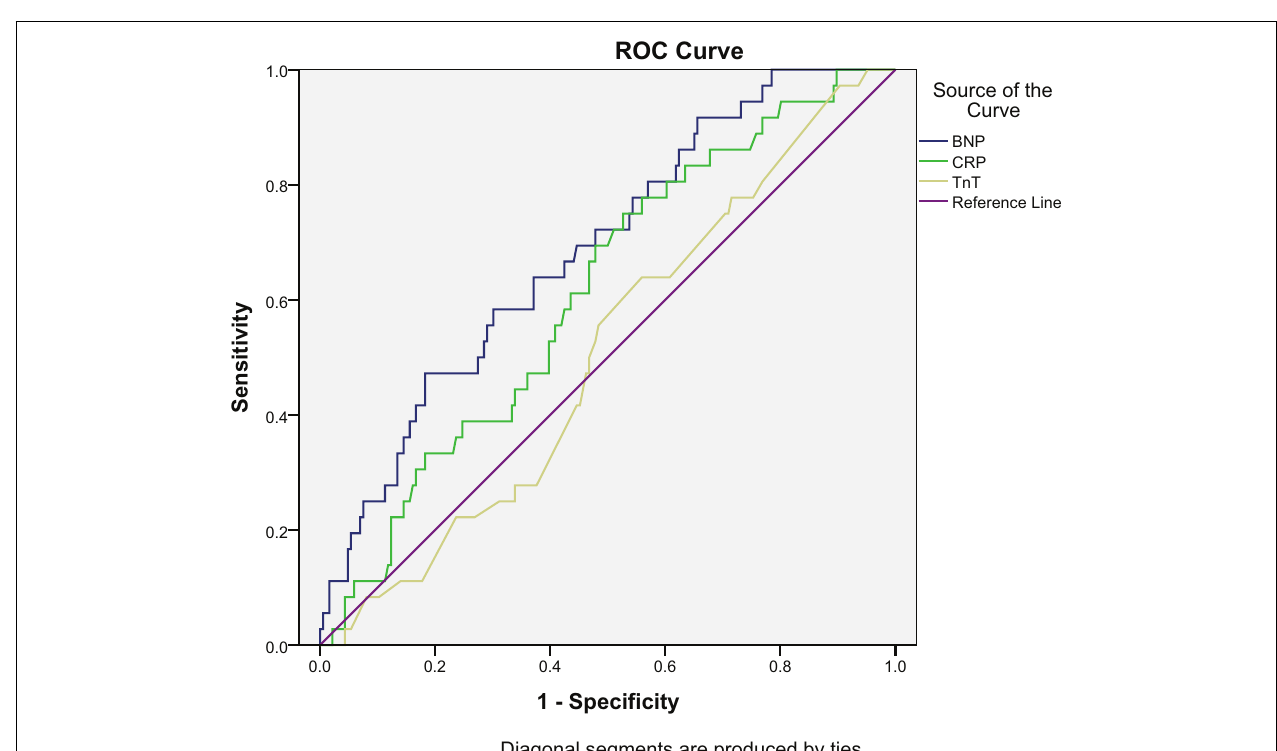
FIGURE 6 | ROC for cardiac death at 2years: BNP, CRP, andTnT